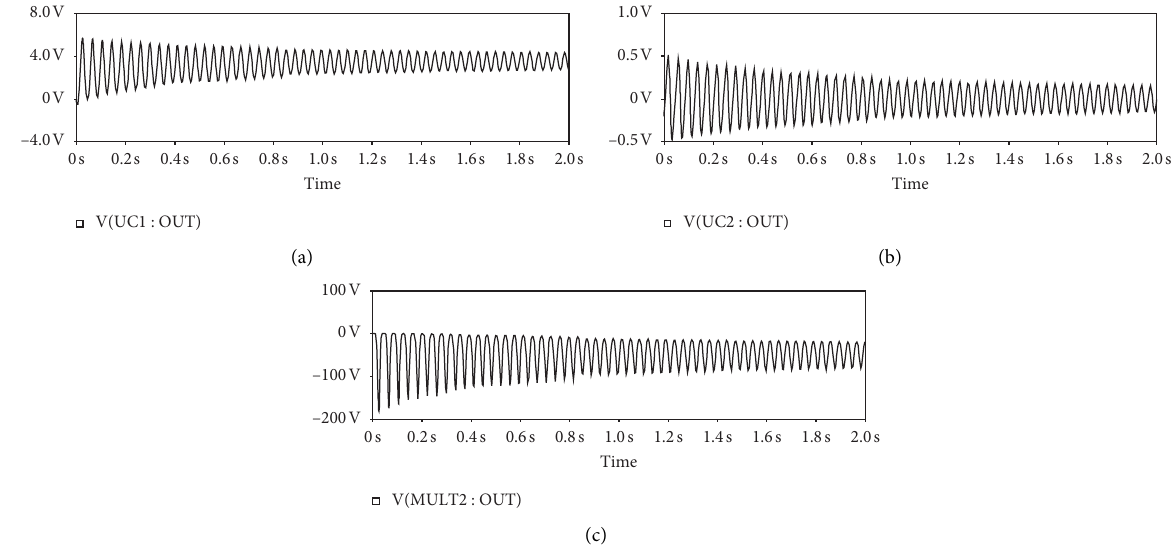
Figure 8: Output voltages of (a) amplifier with capacitor C � 100nF , C C 1